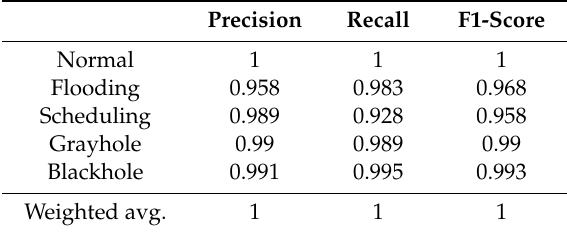
Table 8. Average results of precision, recall, and F1-score, and their weighted average for the 10 fold cross validation.